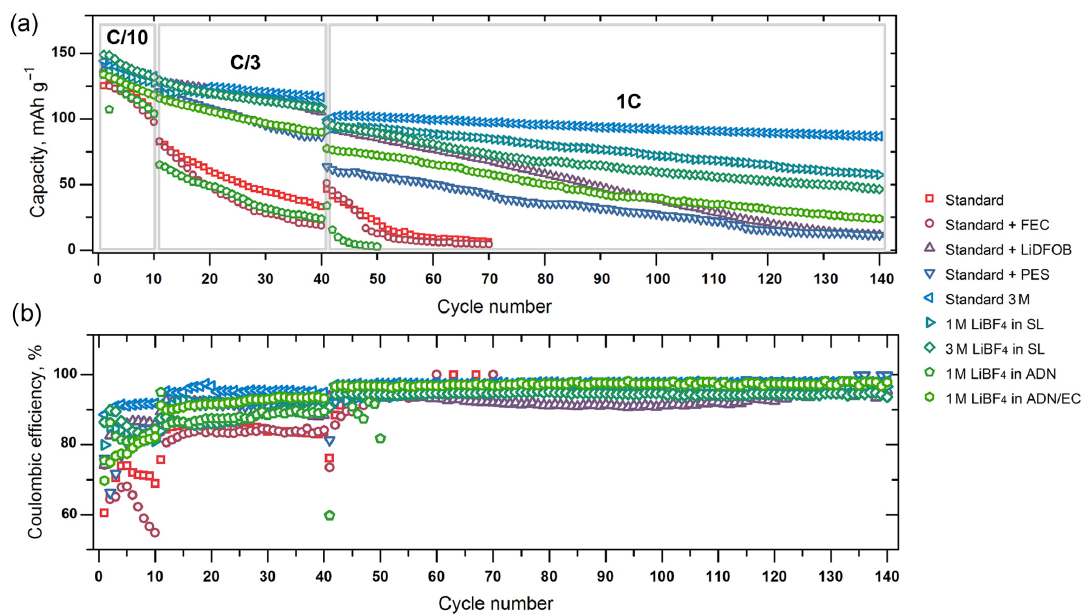
Figure 3. Dependence of the discharge capacity ( a ) and Coulombic efficiency ( b ) of LiNi 0.5 Mn 1.5 O 4 -based lithium half-cells cycled at C/10, C/3 and 1C rates on the number of cycle. (b) The Coulombic efficiency of all the studied cells falls short of the needs for real